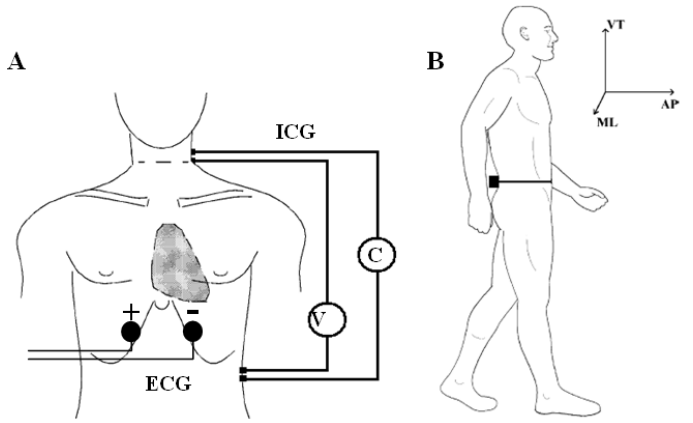
Figure 2. Experimental set-up. ( A ) Electrode positioning: C is the current injecting electrodes and V the voltage measuring electrodes for the impedance cardiograph while the ECG bipolar derivation is fixed under the sternum; ( B ) The wearable unit and the acceleration sensing axes (ML: medium-lateral, AP: antero-posterior, V: